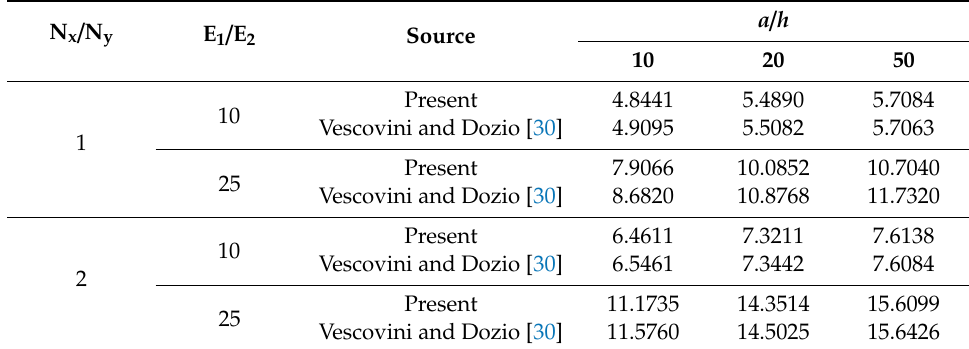
Table 3. Validation of nondimensional buckling load λ = ( λ b 2 /E 2 h 3 ) for a bi-axial buckling (N x / N y ) of simply supported (0 ◦ / 90 ◦ / 0 ◦ ) cross-ply square laminated plate: G 12 = G 23 = 0.6 E 2 , G 23 = 0.5 E 2 , ν = 12